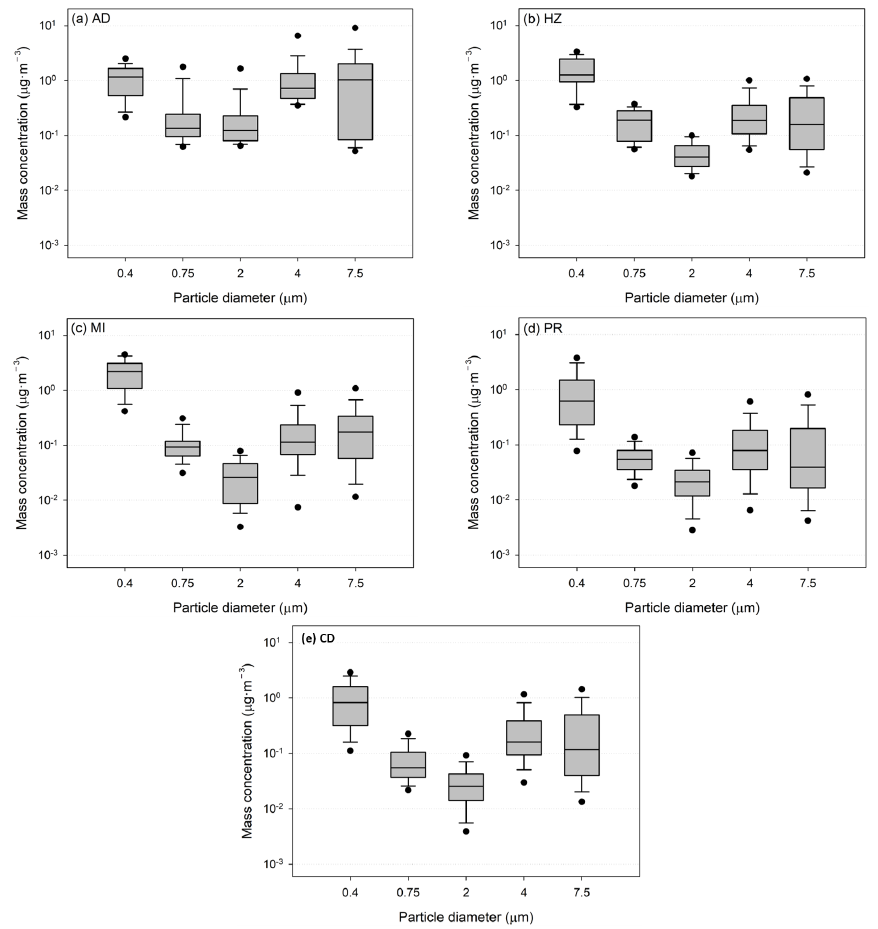
Figure 5. Aerosol mass concentration size distribution for cases of the following: ( a ) Asian dust (AD), ( b ) haze (HZ), ( c ) mist (MI), ( d ) precipitation (PR), and ( e ) clear days (CD) over the entire analysis period. Table 2. Statistical summary for the results of aerosol mass concentration by particle size ( D , μ m) for the instances of meteorological phenomena; all variables are expressed in μ g ∙ m − 3 .